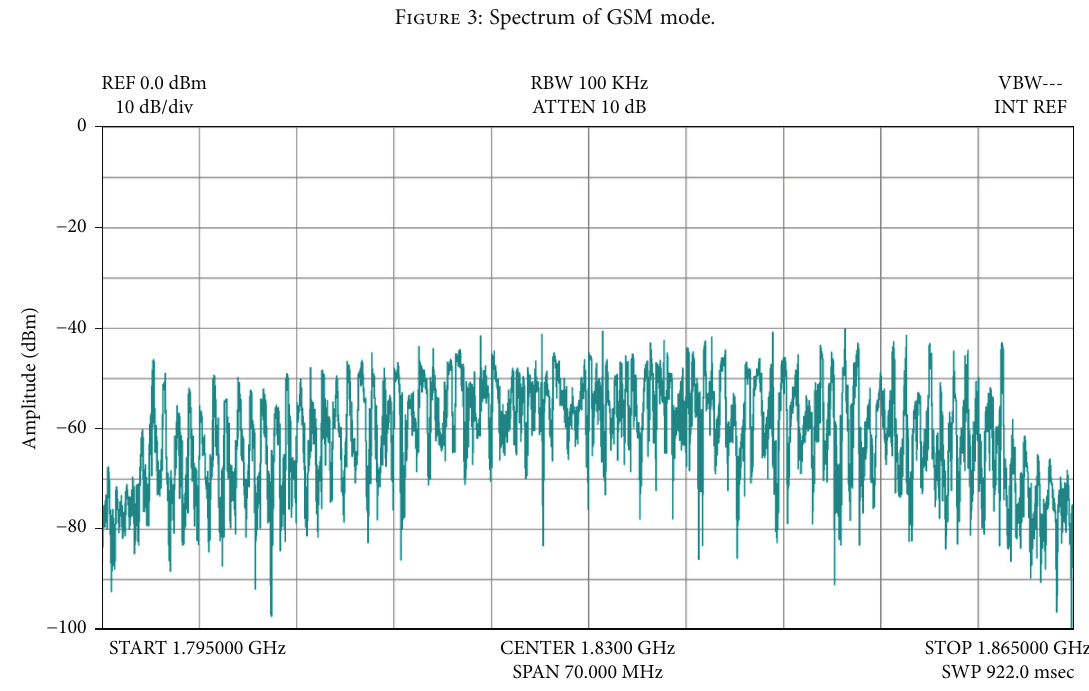
Figure 4: Spectrum of DCS